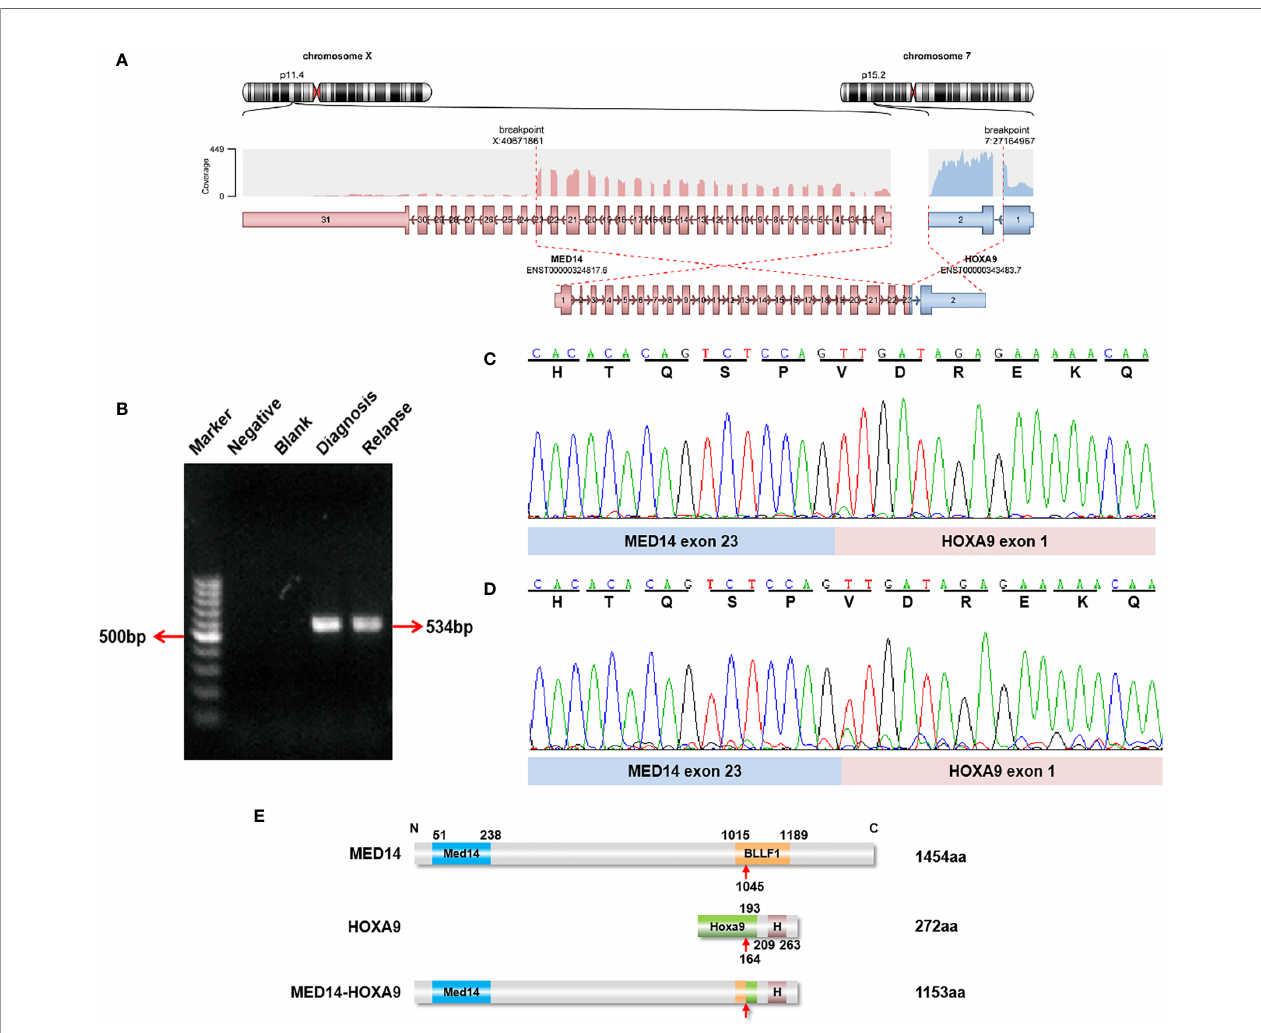
FIGURE 1 | Identi fi cation of recurrent MED14-HOXA9 fusion transcripts. (A) RNA sequencing analysis revealed one breakpoint in exon 23 of the MED14 gene and one breakpoint in exon 1 of the HOXA9 gene. (B) A product of 534 bp was detected by RT-PCR in samples taken at diagnosis and relapse. Marker: GeneRuler 100 bp DNA ladder; negative control (with cDNA sample with the JIH-5 cell line); blank control (without cDNA template). (C, D) Sequence alignment of the ampli fi ed product revealed breakpoints between exon 23 of MED14 and exon 1 of HOXA9 at diagnosis (C) and relapse (D) . (E) Schematic diagram of the MED14 and HOXA9 proteins and the MED14 - HOXA9 fusion protein. The breakpoint is indicated by a red arrow. Med14, Mediator complex subunit MED14 ; BLLF1, Herpes virus major outer envelope glycoprotein (BLLF1); HoxA9, HoxA9 activation region; H, Homeobox